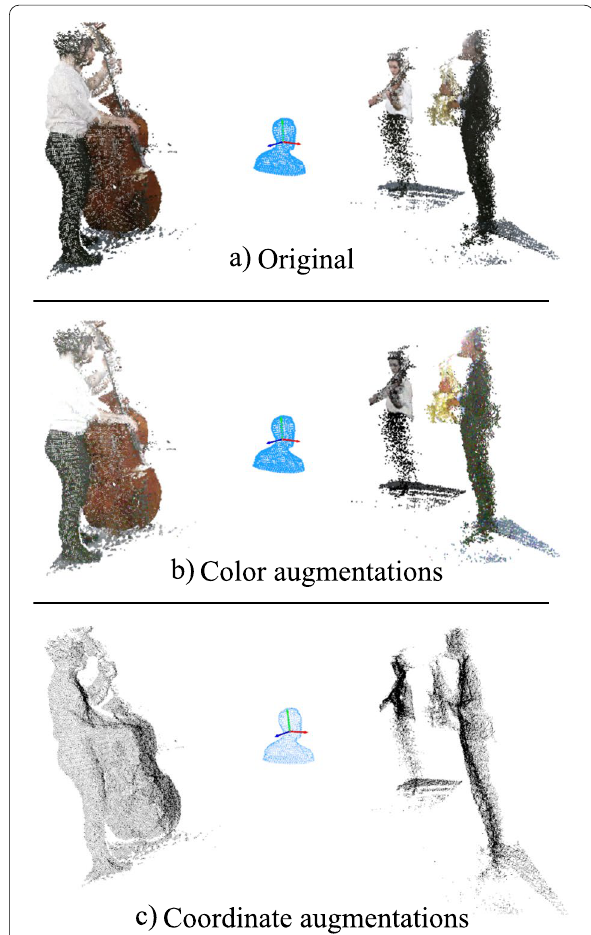
Fig. 3 Illustration of the augmentation operations applied to a 3D point cloud scene. a Original scene. b Color augmentations applied to the original scene. Color augmentations include modifying the brightness and intensity of the sound sources as well as distort the color of each point using Gaussian noise. c Coordinate augmentations applied to the original scene. Coordinate augmentations include random shearing along all axes and random translation along the stature